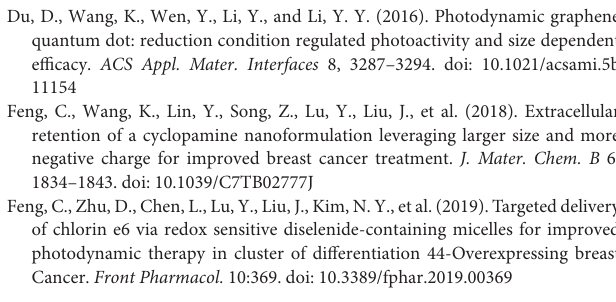
were observed in animal experiments. Therefore, this